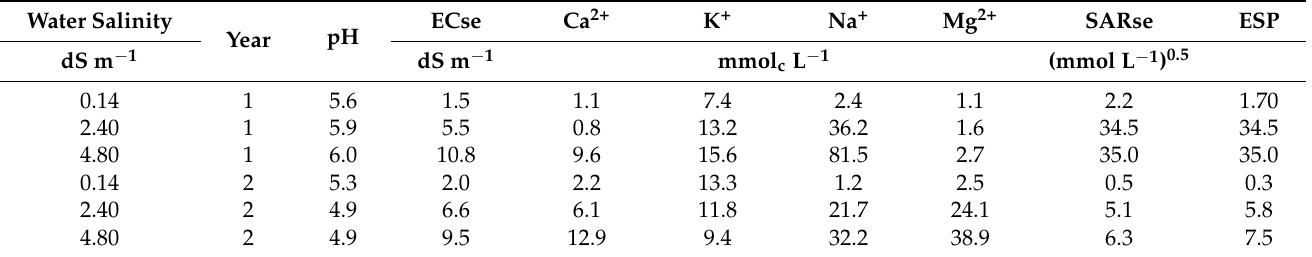
Table 3. Mean values of soil chemical attributes (0–0.20 m depth) at each salinity level. Samples were taken from the plots in the first and second years of